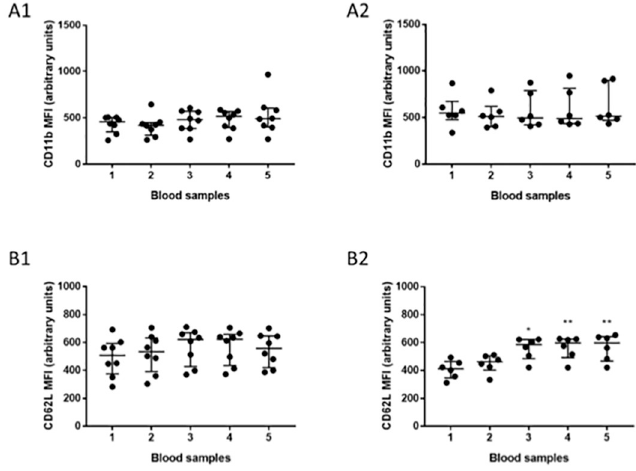
Fig 2. Neutrophil priming status. Data are presented as scatter plots with median (middle bar) and interquartile range (whiskers). Left-sided graphs represent cohort 1 and right-sided graphs cohort 2. [A1] and [A2] MFI of CD11b. [B1] and [B2] MFI for CD62L. The Friedman test with Dunn’s post-hoc multiple comparisons was used to compare values between sample 1 and samples 2–5. Wilcoxon’s matched pairs signed rank test was used to compare samples 4 and 5. � p < 0.05, �� p < 0.005. (Cohort 1: n = 8. Cohort 2: n = 6). Abbreviations: MFI: median fluorescence